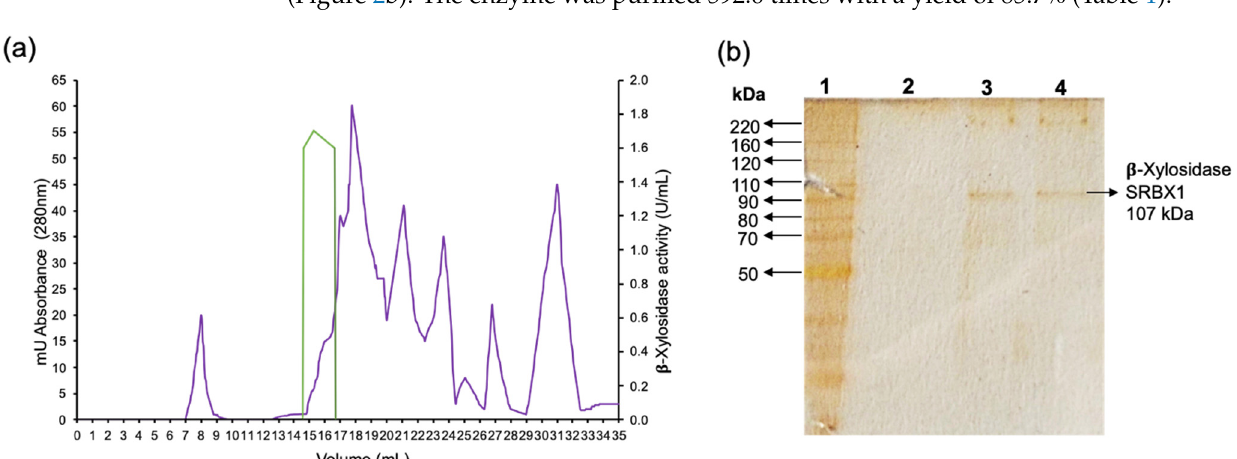
Figure 1. β -xylosidase production from S. reilianum in different culture media. ( a ) Minimum me- dium with glucose; ( b ) minimum medium with corn hemicellulose; and ( c ) minimum medium with corn hemicellulose and glucose. Green line: biomass determined by the increase in the absorbance at 660 nm. Purple line: β -xylosidase activity.